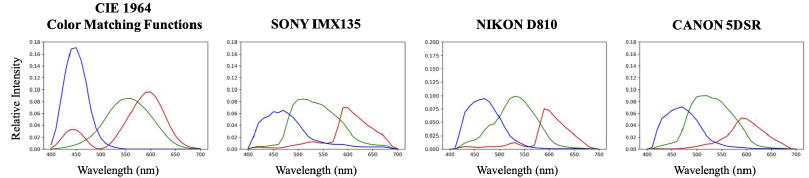
Figure 12. The spectral sensitivities of the ground-truth RGBs used for training (CIE 1964 color matching functions) and for testing (SONY IMX135, NIKON D810 and CANON